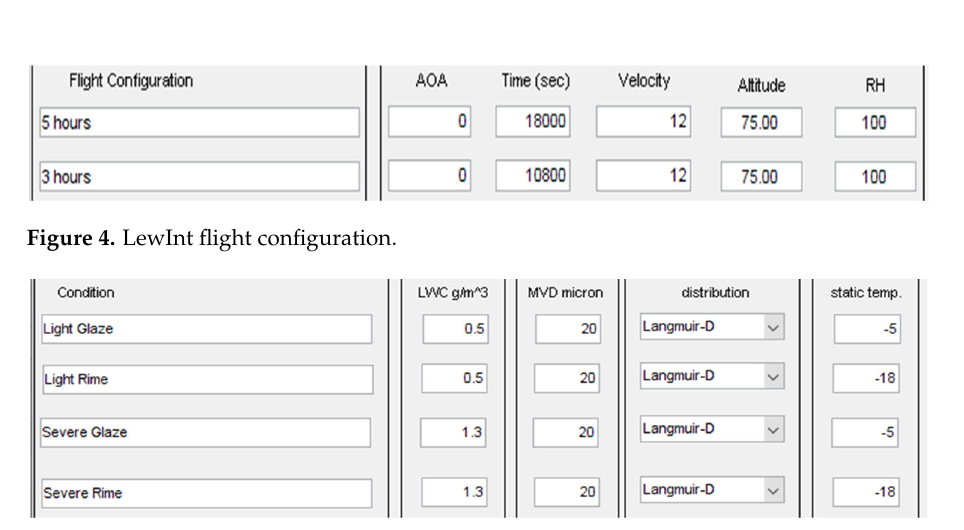
Figure 5. LewInt atmospheric configuration.